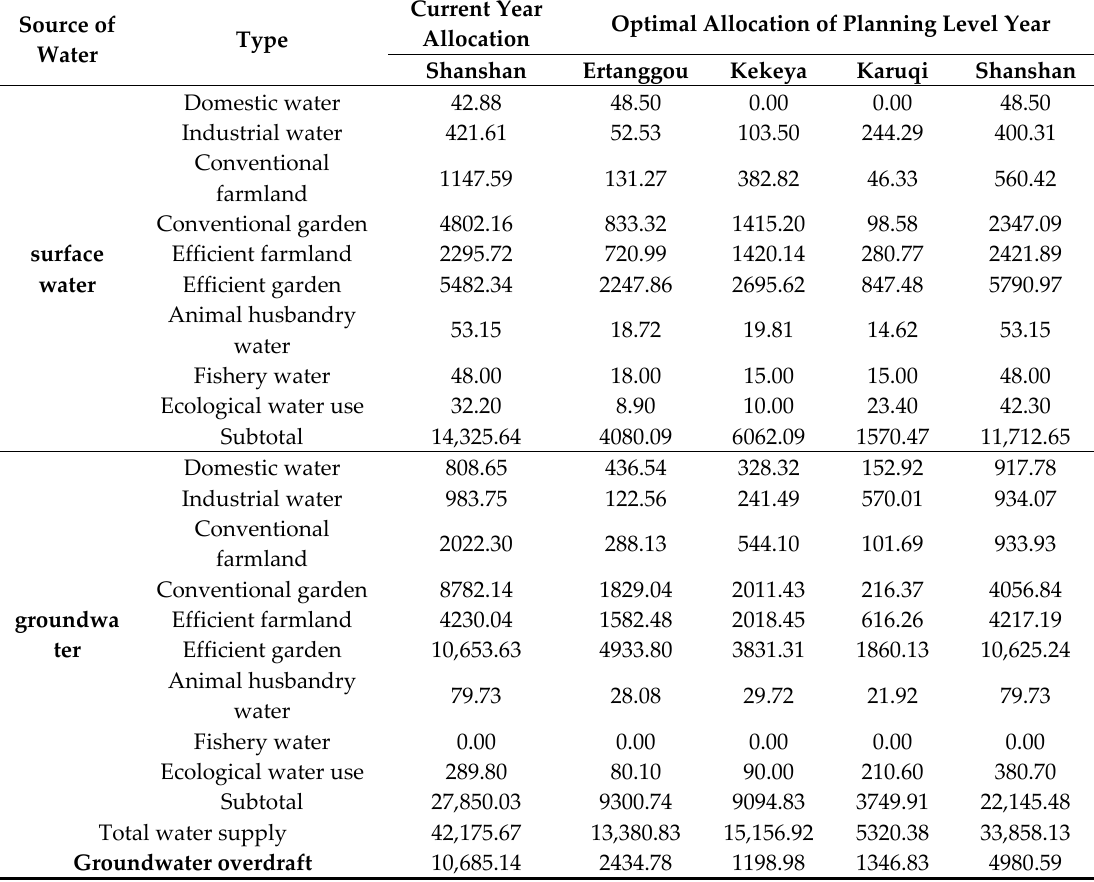
Table 1. Supply and demand balance table of current and planned years in Shanshan under 50% frequency (10 5 m 3